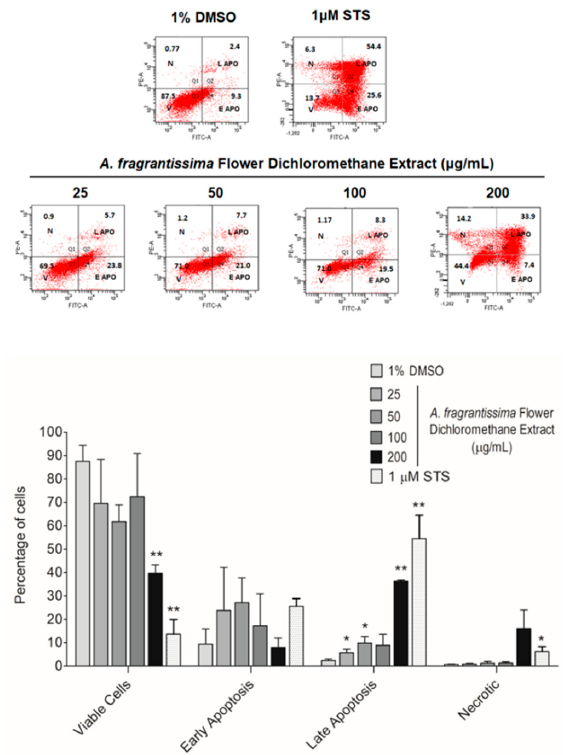
Figure 5. Determination of the apoptotic status in the TNBC MDA-MB-231 cells exposed to A. fragrantissima flower dichloromethane extract. Representative scatter plots indicating the percentage of MDA-MB-231 cells in viability (V), in apoptotic status including early apoptosis (E APO) and late apoptosis (L APO), and in necrotic (N) status, based on Annexin V (-FITC) and PI (-PE) double staining measured by FACS. A. fragrantissima flower dichloromethane extract prompted apoptosis in TNBC MDA-MB-231 cells, in a dose-dependent manner, compared to DMSO-treated cells. STS was used as a positive control. The bar graph presents data as mean ± SD of three separate experiments. * p < 0.05 and ** p < 0.01 vs. DMSO-treated cells.